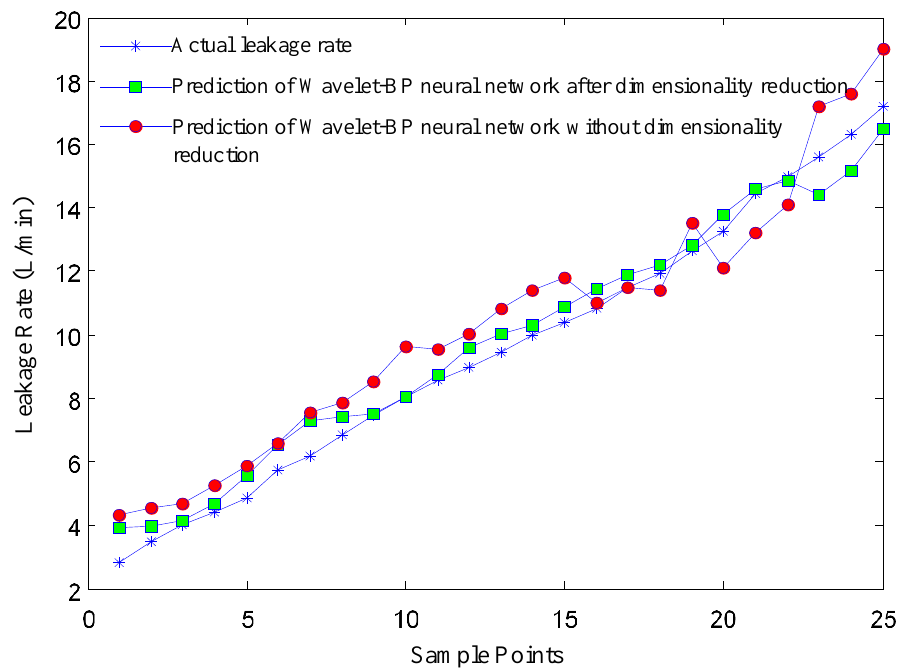
Figure 7. The influence of dimensionality reduction on model prediction results.